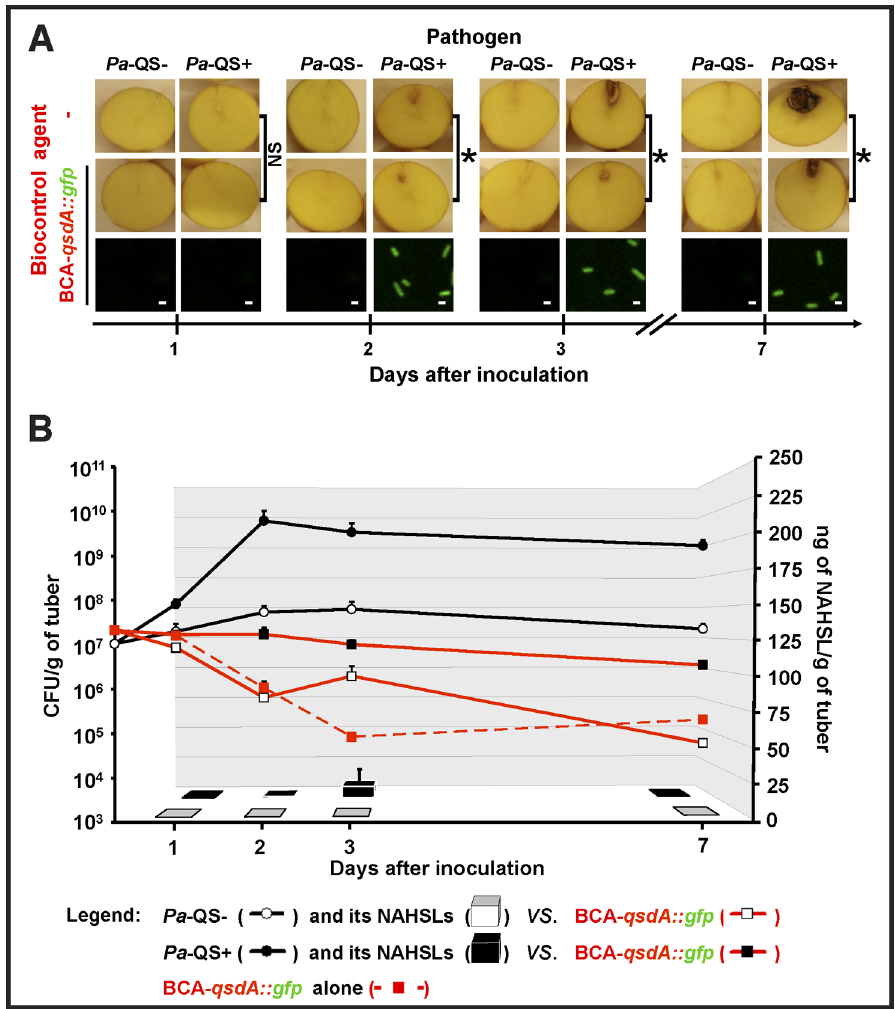
Figure 1. Induction of qsdA gene transcription, NAHSL-breakdown and biocontrol activity of R.erythropolis in potato tubers. (A) qsdA gene transcription and biocontrol activity of the R. erythropolis BCA- qsdA::gfp against P. atrosepticum 6276 defective ( Pa -QS – ) or not ( Pa -QS + ) for NAHSL production were analyzed at 1, 2, 3 and 7 days after inoculation of S. tuberosum var. Allians tubers. For the controls, one of the two strains was replaced in the inoculum with a 0.9% NaCl solution. Asterisks indicate significantly less severe maceration symptoms in the presence of the BCA- qsdA::gfp , as assessed with the Mann and Whitney test ( a =0.05). The fluorescence of the BCA- qsdA::gfp was analyzed by confocal laser scanning microscopy. (B) The numbers of P. atrosepticum (black lines) and R. erythropolis (red lines) bacteria per unit weight (CFU/g fresh weight of potato tubers), and NAHSL concentration (ng/g of potato tubers; black and white bars) were determined for each condition in potato tubers. For lines and bars, each value is the mean of three replicates with the standard deviation indicated. NS, non-significant; NAHSL, N -acyl homoserine